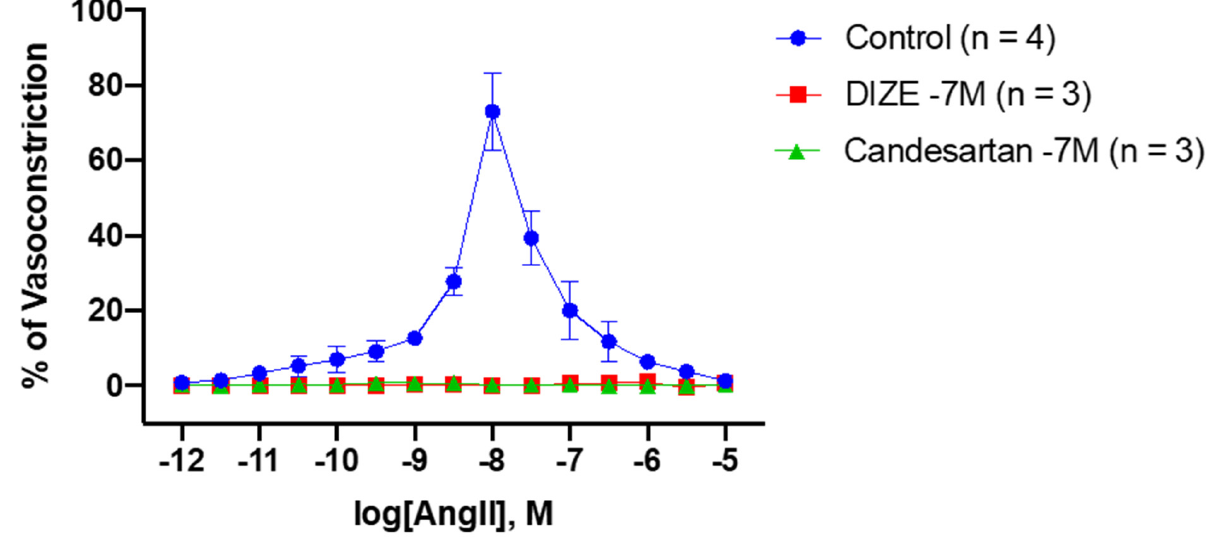
Figure 2. Inhibitory effect of DIZE and candesartan during AngII-induced vasoconstriction re- sponses in rabbit iliac arteries. To determine the ability of DIZE to inhibit the vasoconstriction responses to cumulative doses of AngII, the iliac rings were incubated with DIZE and compared to the candesartan and control rings. As expected, incubation with candesartan, a known ARB, potently inhibited the vasoconstriction responses to AngII at doses AngII (10 − 9.0 M) to AngII (10 − 6.5 M) (mean ± SEM is shown, the significance presented in Table 1). Similar results were observed in rings incubated with DIZE at doses AngII (10 − 9.0 M) to AngII (10 − 6.5 M) (mean ± SEM is shown, the signif- icance presented in Table 1). Table 1. Significance of vasoconstriction in response to the AngII dose response between the control, candesartan and DIZE obtained from Figure 2.